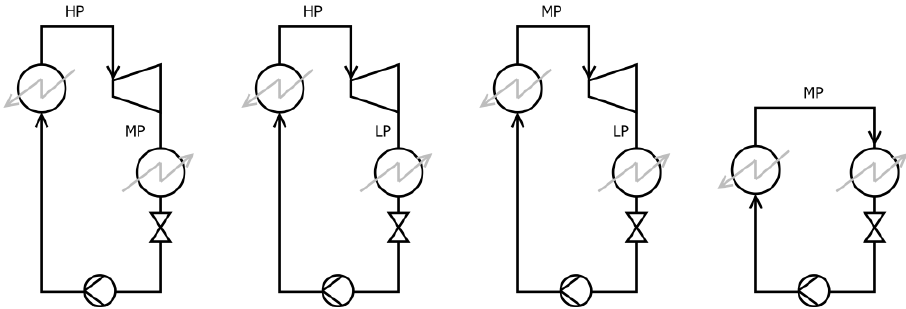
Figure A4. Elementary cycles considered to model the steam network in Figure A3.